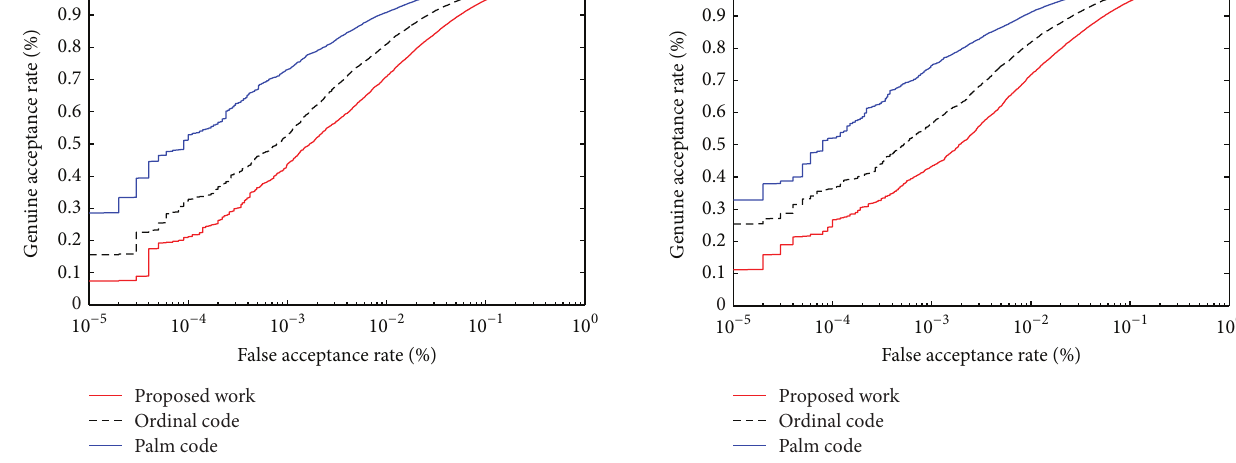
Figure 13: ROC curve using local features of proposed DOST for COEP palmprint database.